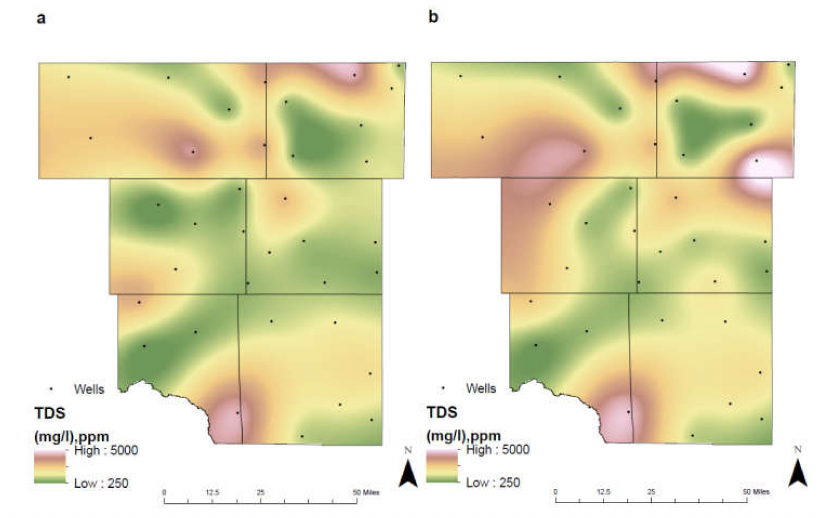
Figure 5. Spatial distribution of TDS in the study area for ( a ) 1992–2005 and ( b )